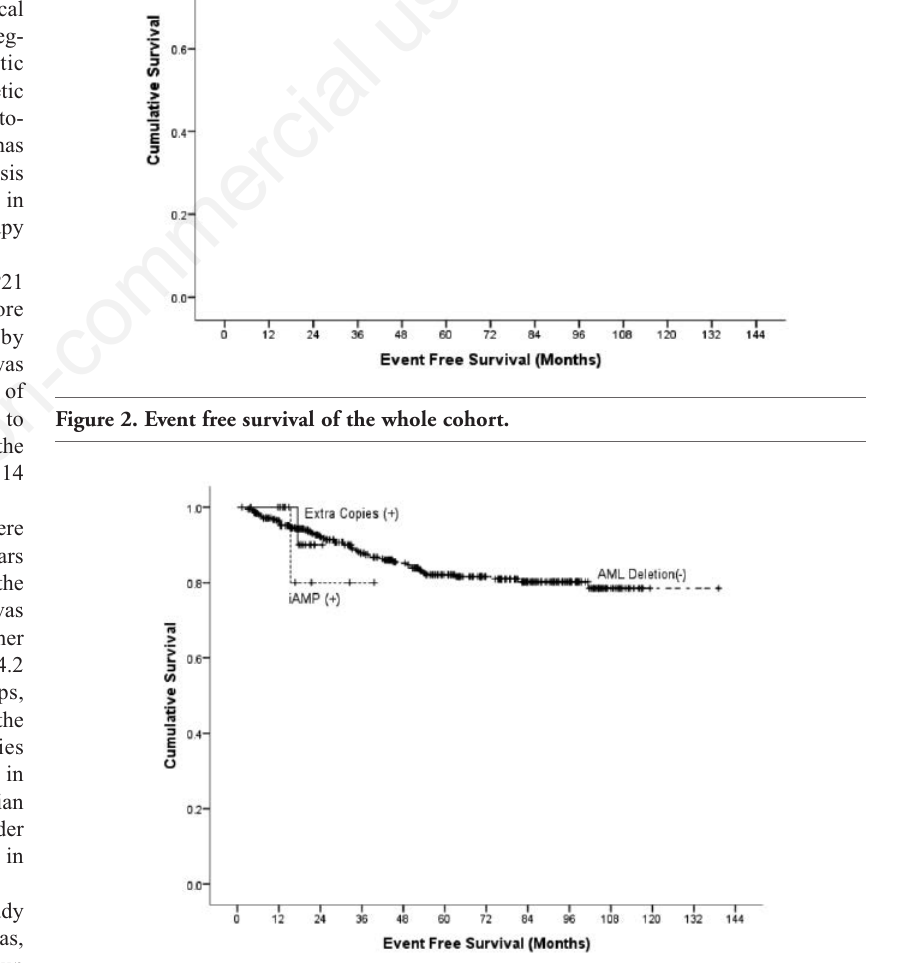
Figure 3. Event free survival of the three